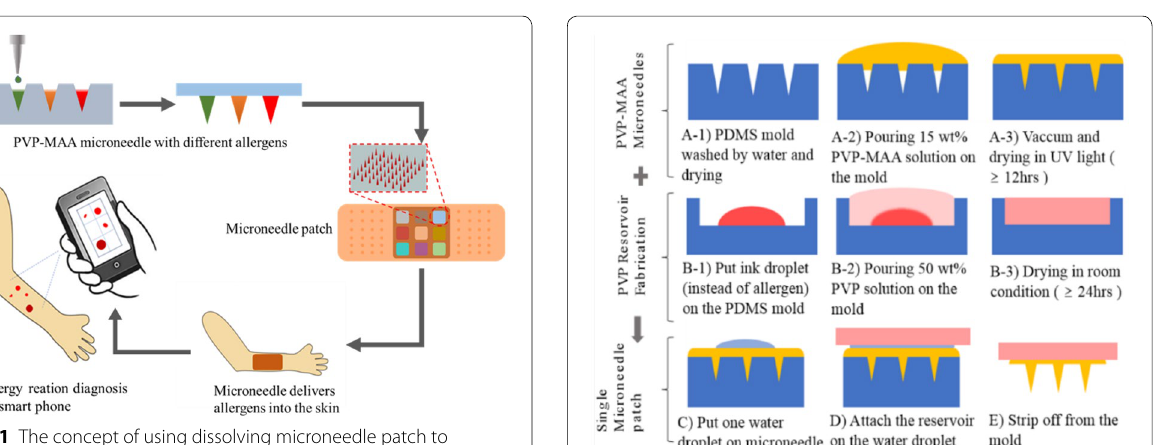
4 MN × 2 mm). SEM images = 200 µm) ( b ) and 4 4 MN patch (scale = ×